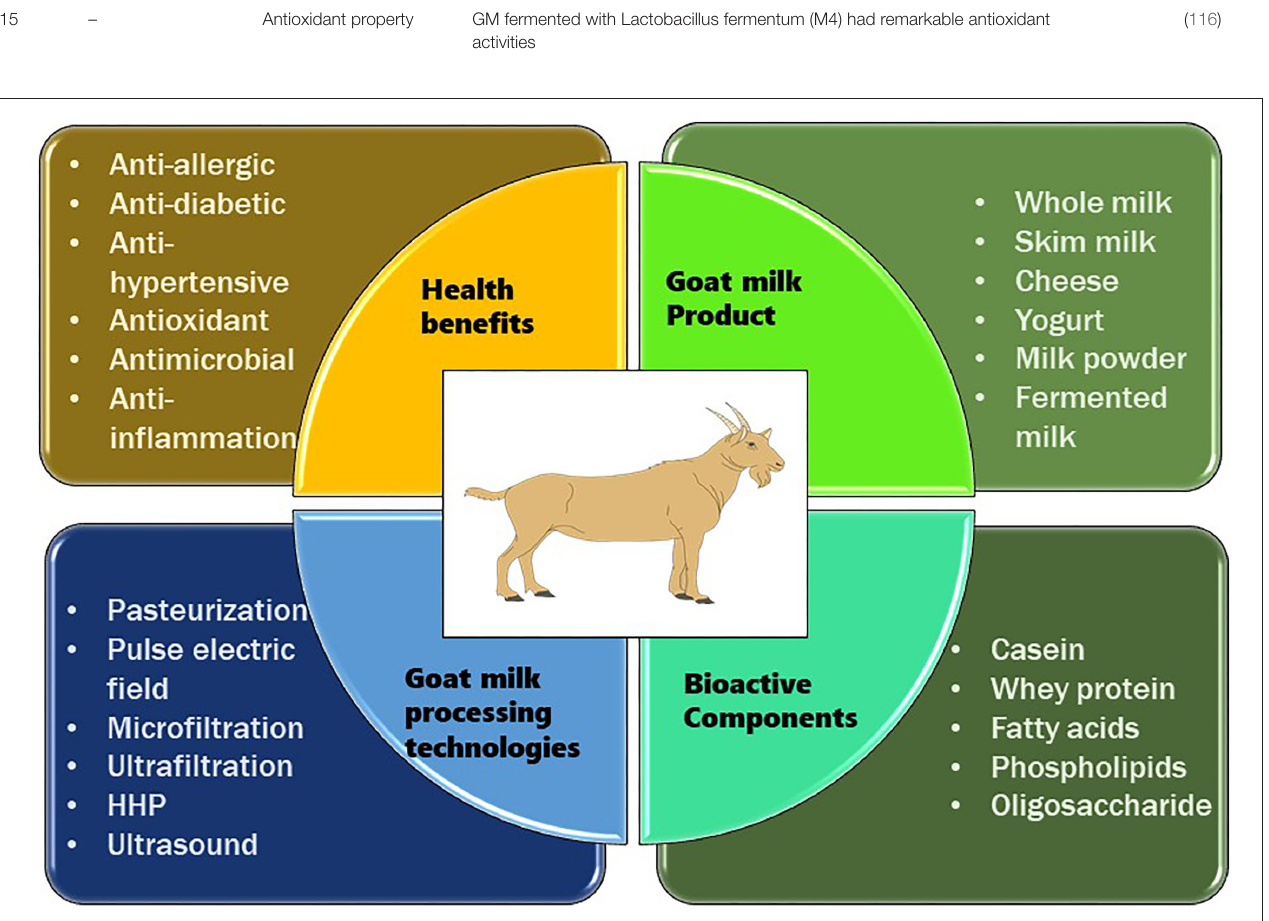
FIGURE 1 | Processing, bioactive compounds, & health benefits of goat milk.